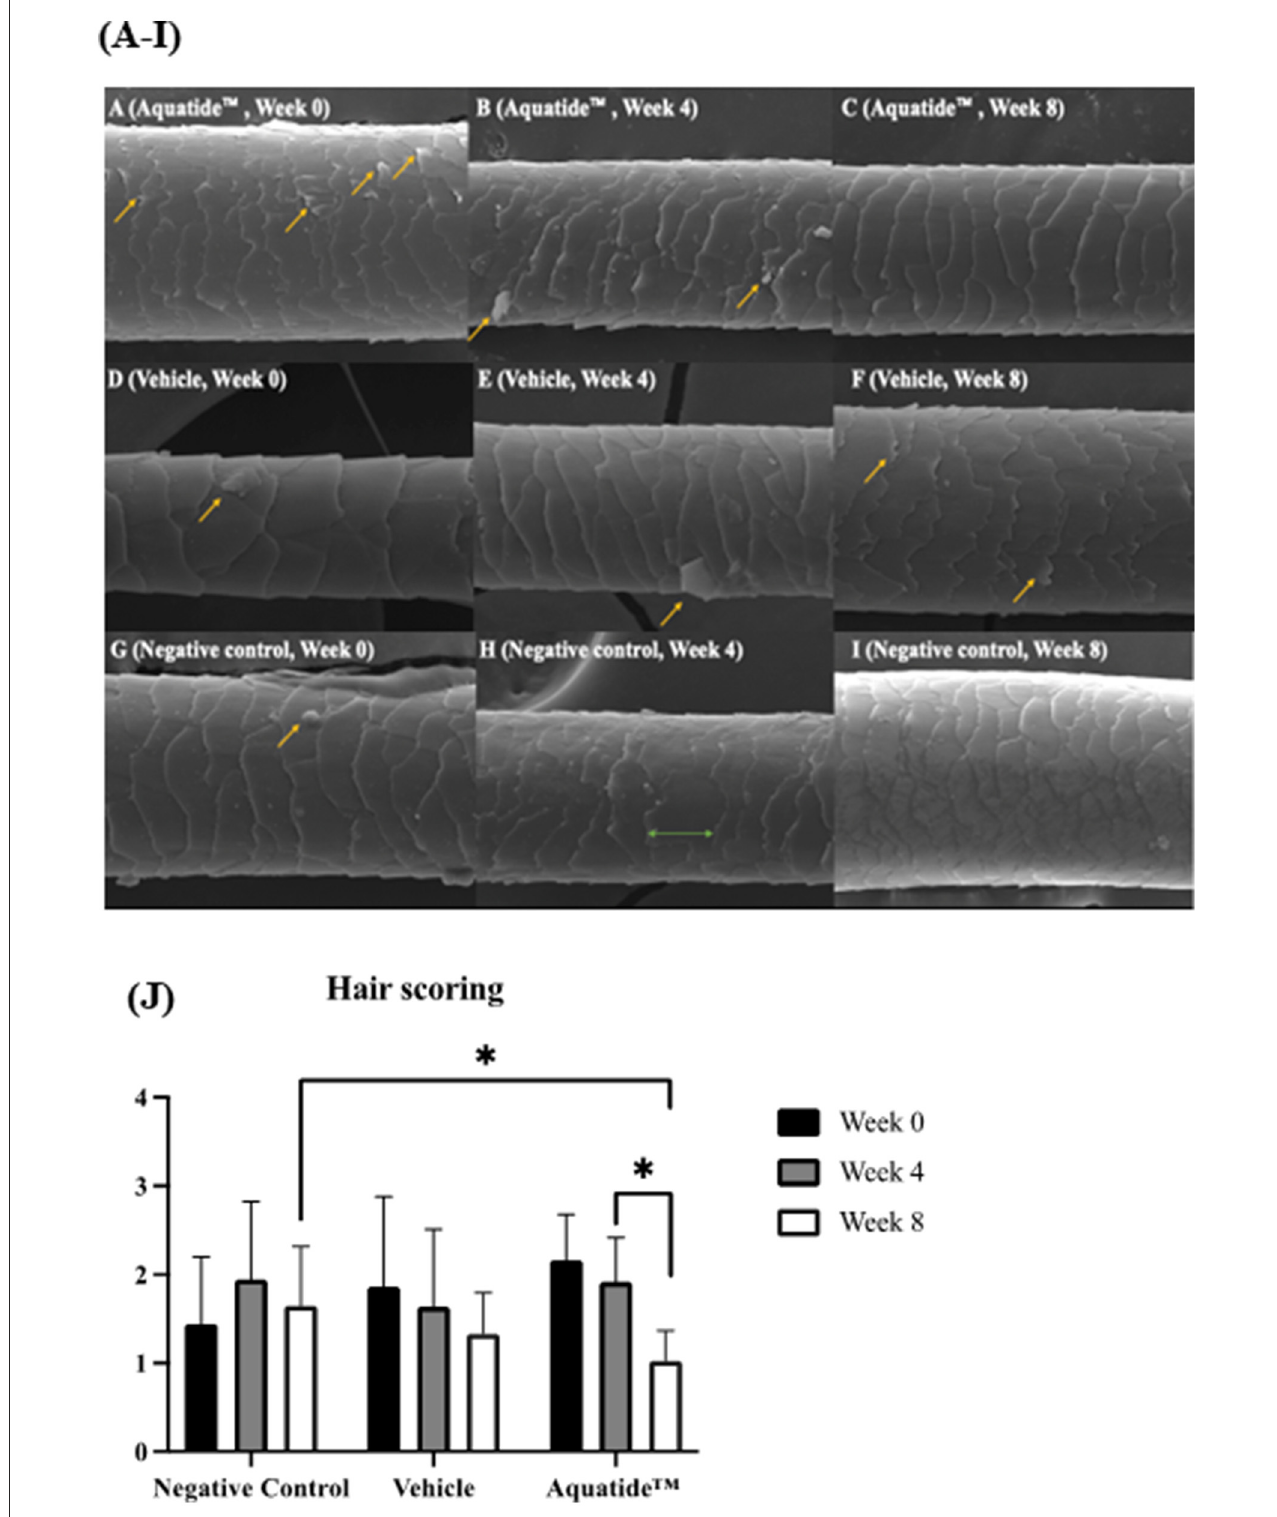
FIGURE4 Induction of autophagy improves hair surface damage and hair cuticle layers in dogs with underlying diseases. (A–I) Scanning electron microscopic photographs for evaluating hair surface damage. The arrows points to the hair surface damage. It was confirmed that the hair surface was improved at week 8 after Aquatide TM was applied. (J) Hair scoring in the treatment group. When Aquatide TM was applied, hair scoring was significantly decreased at week 8 compared to week 0 and week 4, and was significantly lower than in the negative control. * p <